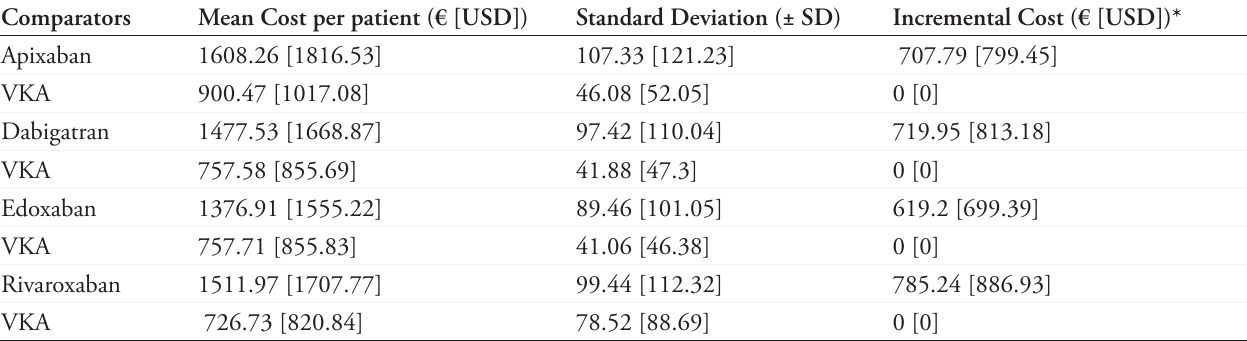
Table 6: Results of probabilistic sensitivity analysis (Monte Carlo Simulation)